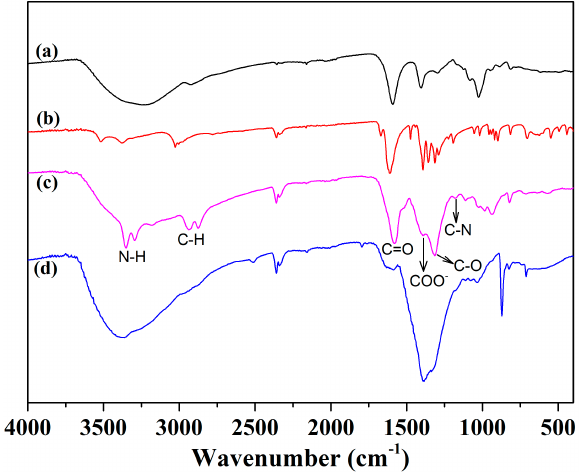
Figure 2. FTIR spectra of ( a ) sodium alginate, ( b ) EDTA salt, ( c ) Alg-EDTA, and ( d ) Cd 2+ -loaded Alg-EDTA.